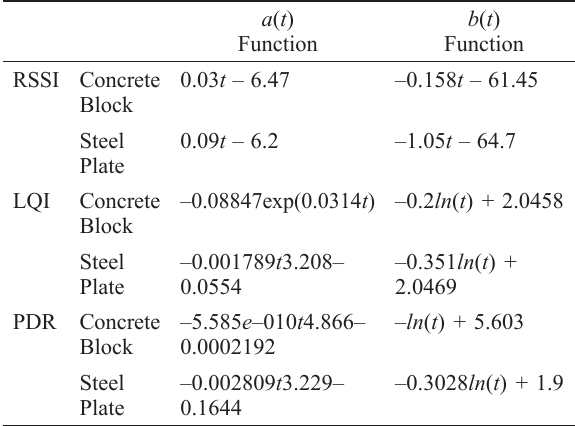
Table 4. List of coefficient functions for measurement index in each material